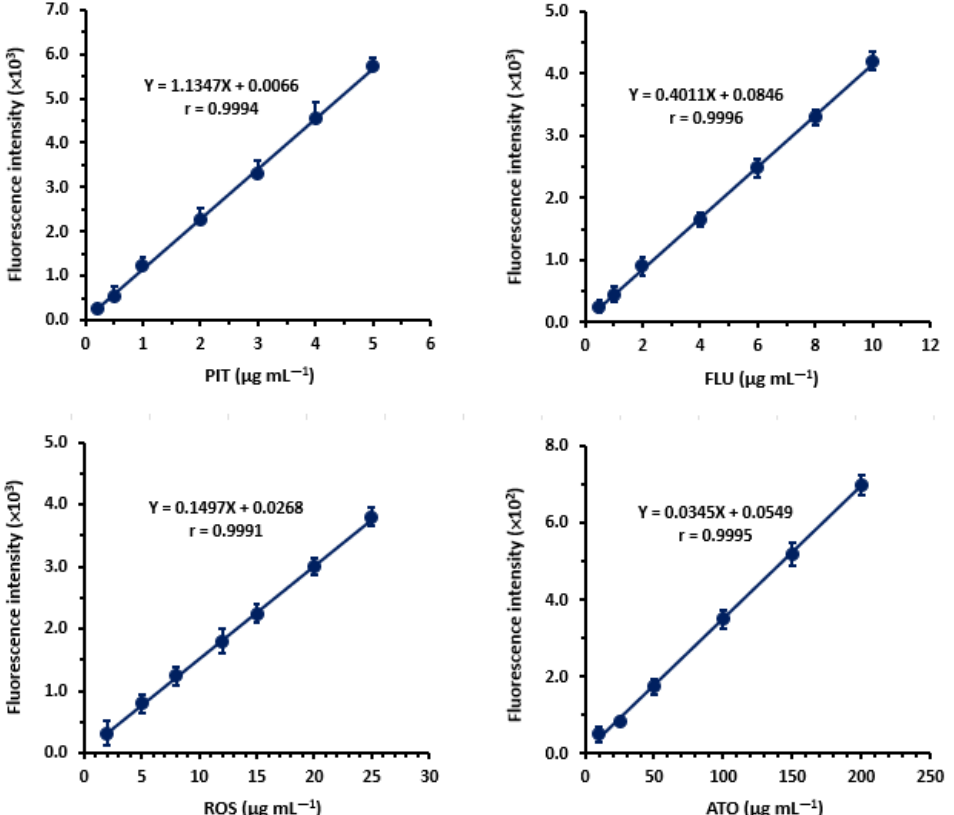
Figure 7. Calibration curves for determination of statins by the proposed MW-SFA. Values of fluorescence intensity are mean of 5 determinations ± SD.